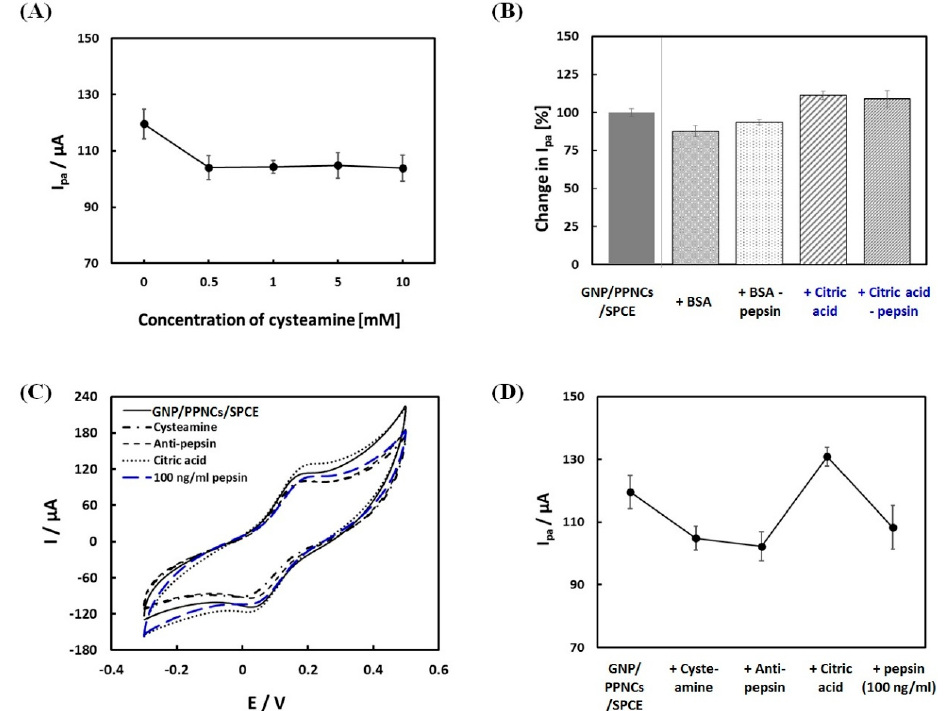
Figure 3. ( A ) Changes in anodic peak current (I pa ) of the GNP/PPNCs/SPCE electrode according to cysteamine concentration; ( B ) changes in I pa of GNP/PPNCs/SPCE electrode before and after the treatment of BSA and citric acid, as well as after incubation of 50 ng/mL pepsin, respectively; ( C ) electrochemical stepwise characterization of pepsin immunosensor using cyclic voltammetry (CV). CV response of GNP/PPNCs/SPCE electrode (black line), after cysteamine (mixed line), and anti-pepsin (broken line), citric acid (dotted line), and 100 mg/mL pepsin (blue broken line) treatments, respectively; and ( D ) the corresponding I pa of GNP/PPNCs/SPCE electrode, after cysteamine, anti-pepsin, citric acid, and 100 mg/mL pepsin treatments, respectively.